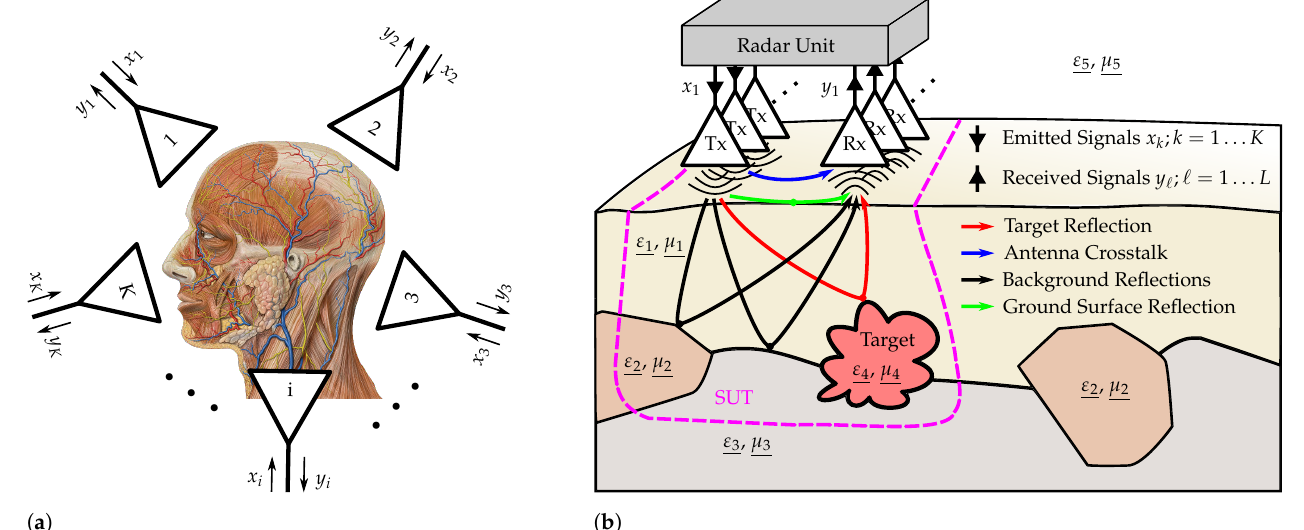
Figure 1. Different applications of MIMO imaging using arbitrarily arranged antenna arrays. ( a ) Med- ical imaging—conformal array: Detection of head arterial movements (head adapted from [9]); ( b ) MIMO GPR—planar array: Detection of shallow-buried improvised explosive devices